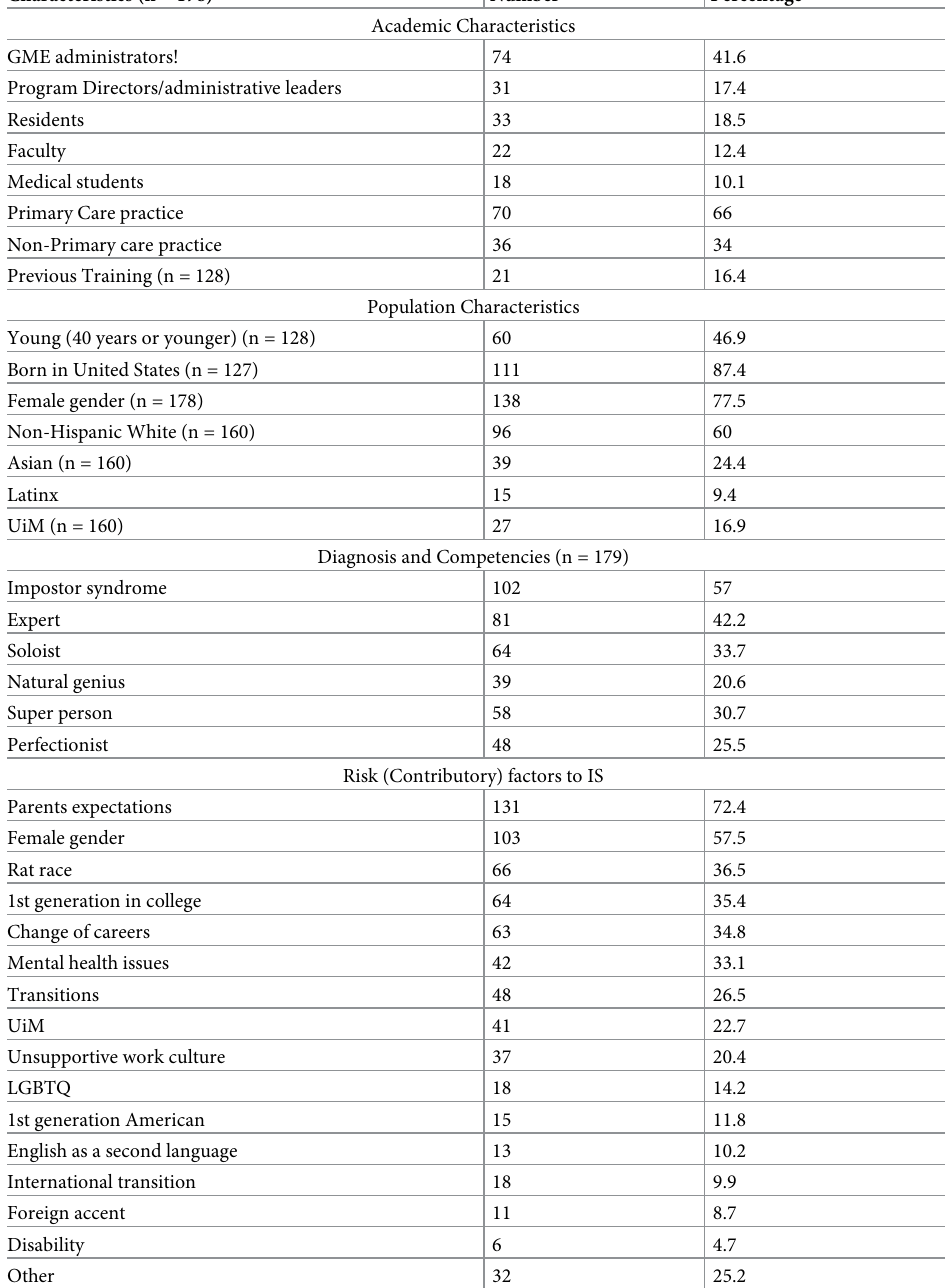
Table 1. Frequency of Impostor syndrome and competency subtypes, demographics, other characteristics, and contributory factors as identified by